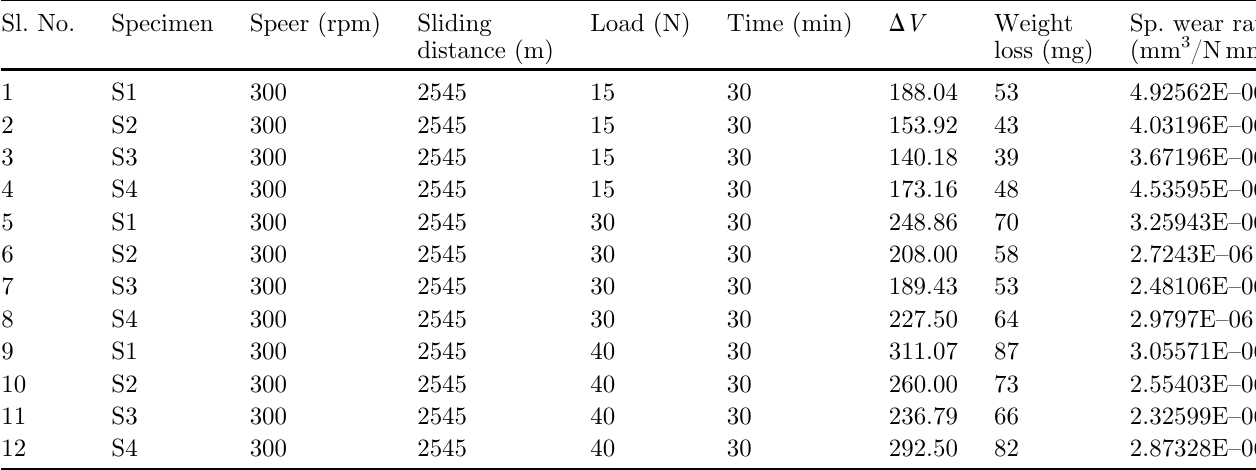
Table 7. Results of dry sliding